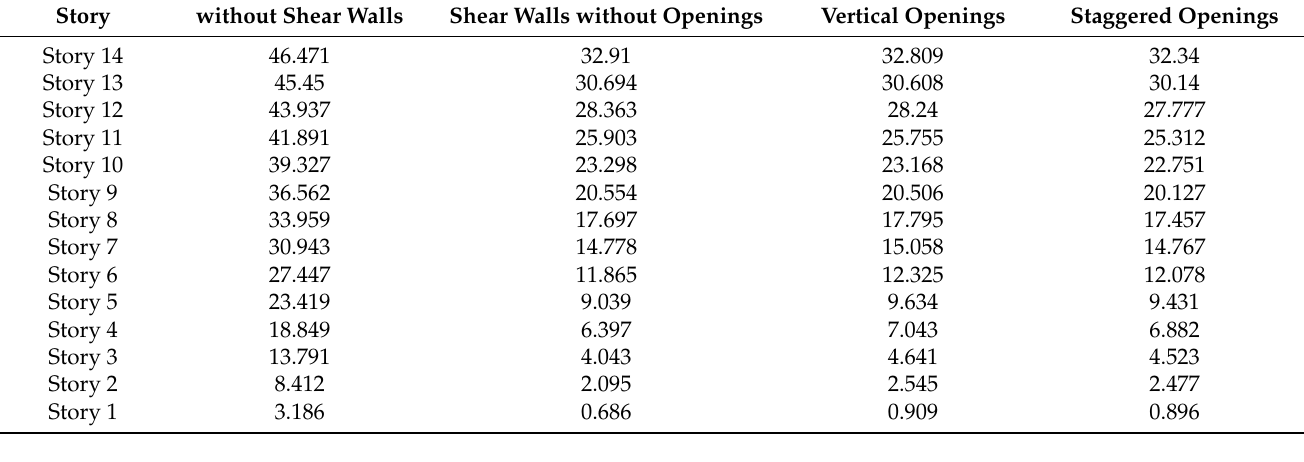
Table 9. Comparison of the story displacements, time history, and Y-direction (mm).